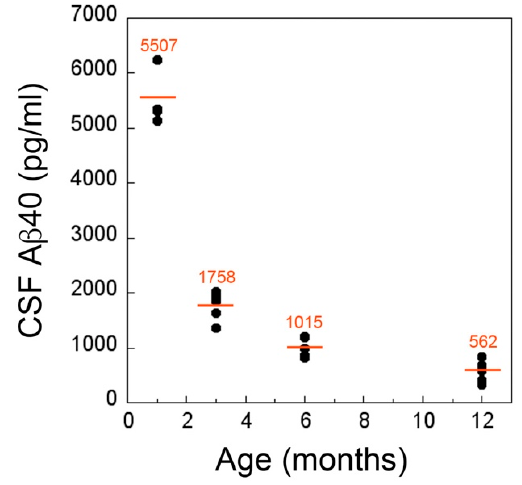
Figure 5. Decreased levels of A β 40 in CSF of rTg-DI rats at the inception and progression of microvascular CAA. The levels of A β 40 in CSF collected from rTg-DI rats as they aged from one to twelve months was determined by ELISA. The data show the mean CSF A β 40 levels at each time point from n = 5–6 rTg-DI rats per group. At three months of age, when CAA first appears, there is precipitous drop in CSF A β 40 levels that continue to decline with progressing CAA.